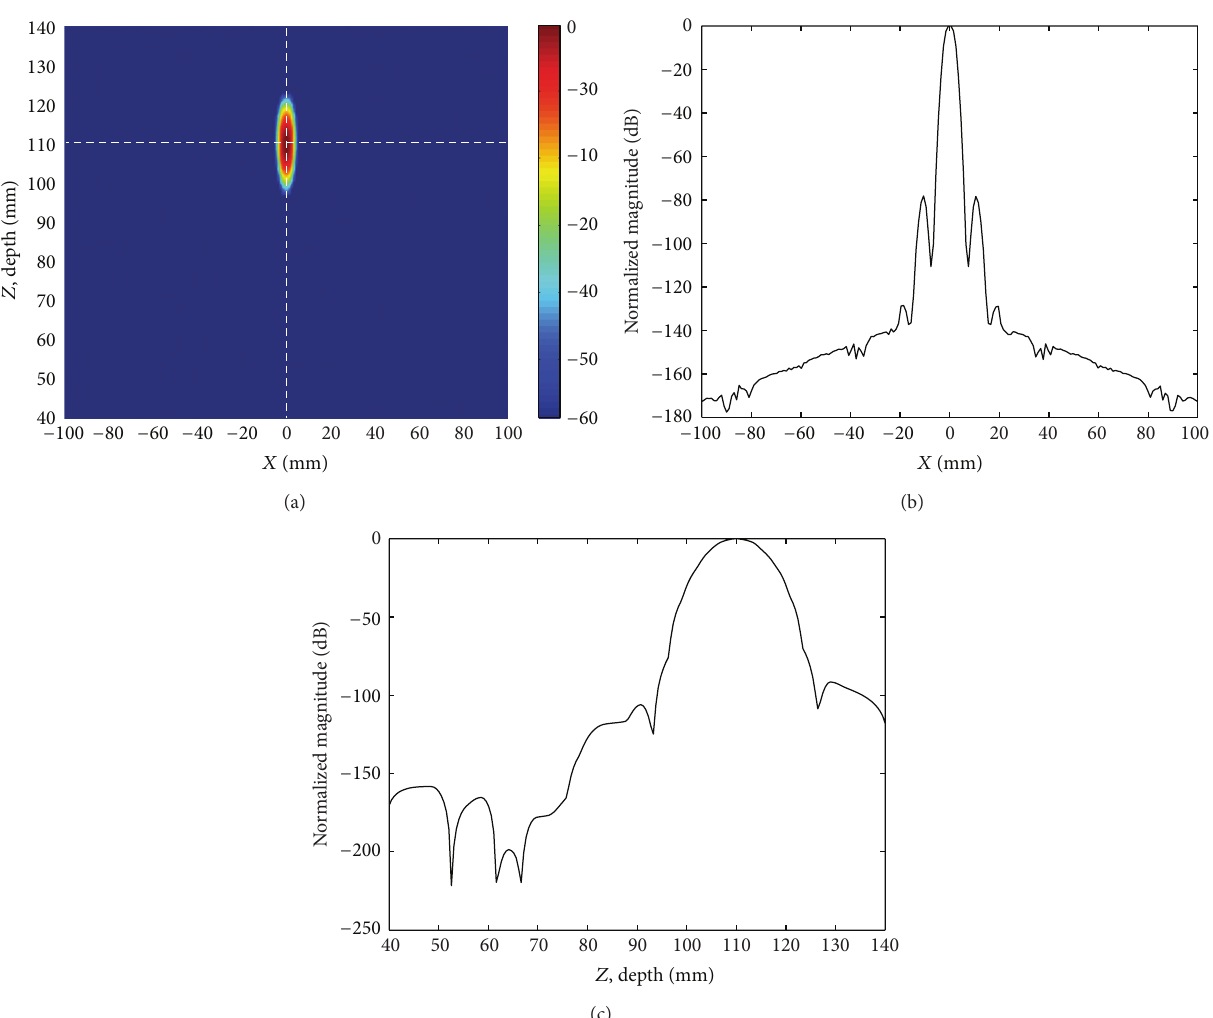
Figure 7: Two-way PSF: (a) on the 𝑥𝑧 plane (magnitude scale is in dB; the dynamic range used for PSF representation is 60dB); (b) profile at a 110mm depth, that is, along the horizontal dashed white line depicted in (a); (c) profile along the range axis ( 𝑥 = 0 ), that is, along the vertical dashed white line depicted in (a). The antenna linear array is aligned along the 𝑥 -axis and centered at the origin of the reference